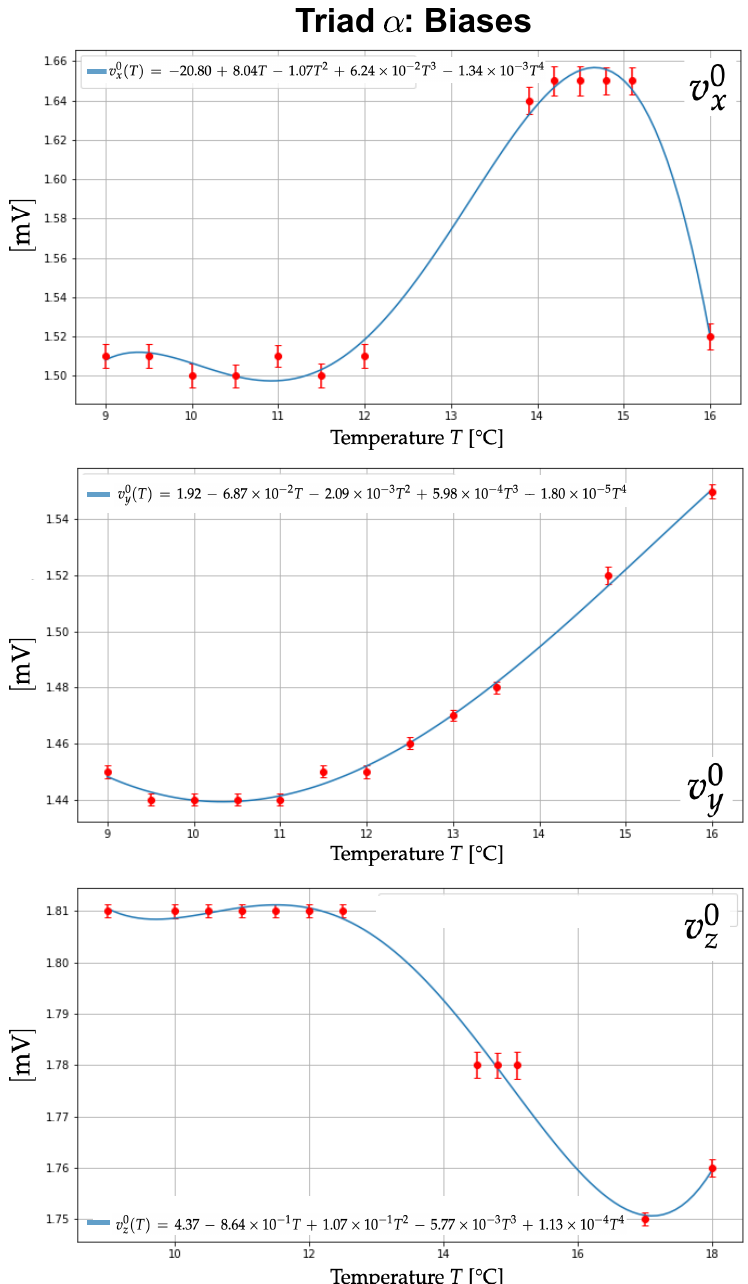
Figure 7. Graphs showing the variation of the accelerometer biases v 0 x ( top ), v 0 y ( middle ) and v 0 z ( bottom ) with temperature for the triad α . The red solid circles correspond to the values of the biases determined by our adjustment method and are plotted with their 1 sigma error bars. The blue curves represent the result of a polynomial fit with fourth-degree polynomials. Expressions of the polynomials are directly written out on the graphs. For all three polynomial fits, the coefficient of determination was found to be 0.993 ( v 0 x ), 0.996 ( v 0 y ) and 0.989 ( v 0 z ). These coefficients did not show a significant increase for polynomial models of degrees greater than 4. The polynomial fits were validated by performing a chi-squared statistical test on the residuals with a 5% risk. This validation required the rejection of some observations that led to the failure of the chi-squared test. The same graphs are available for the triad β